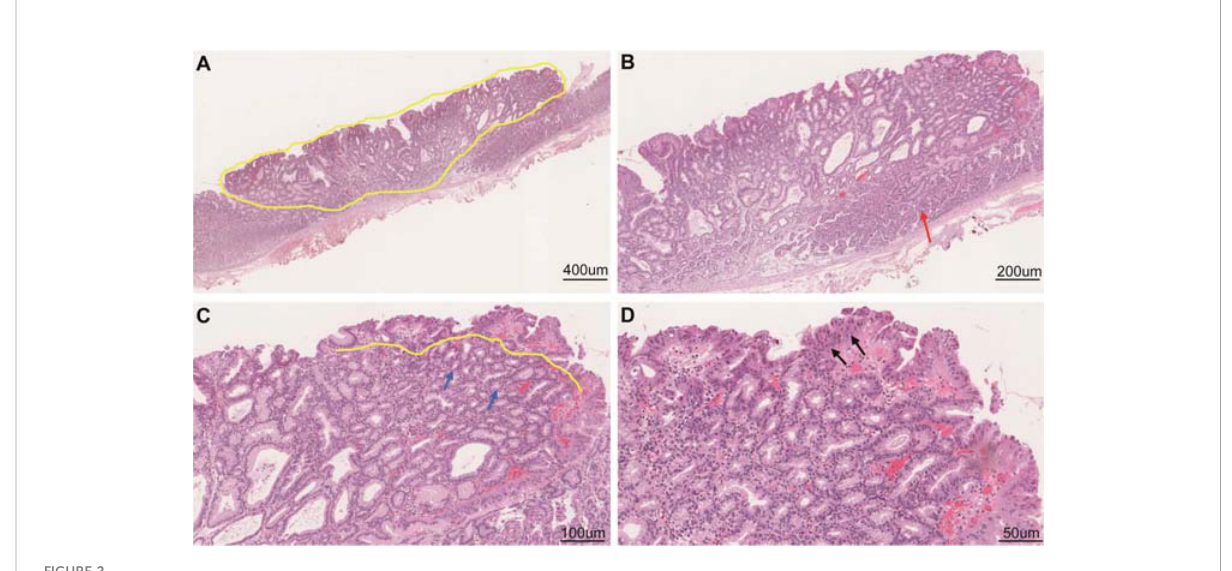
FIGURE 2 Histological examination of the resected specimen. Low-power fi eld (A) and high-power fi eld (B – D) of hematoxylin and eosin staining. Tumor cells were similar to mucous neck cells (C) and foveolar epithelium (D) . Scale bars represent 400 m m (A) , 200 m m (B) , 100 m m (C) , and 50 m m (D) . The yellow dotted line indicates the extent and size of the diagnosed cancer; the red arrow indicates a normal gastric corpus gland; the black arrows indicate suf fi ciently high cellular atypia in the sur fi cial part; and the yellow line and blue arrows indicate that the undersurface part is the cancerous